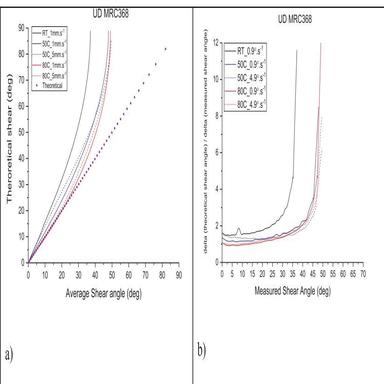
Theoretical and measured shear angles from BE for CEP-UD prepreg; a) a direct comparison, and b) slope of 'theoretical to experimental versus measured shear angles (experimental).